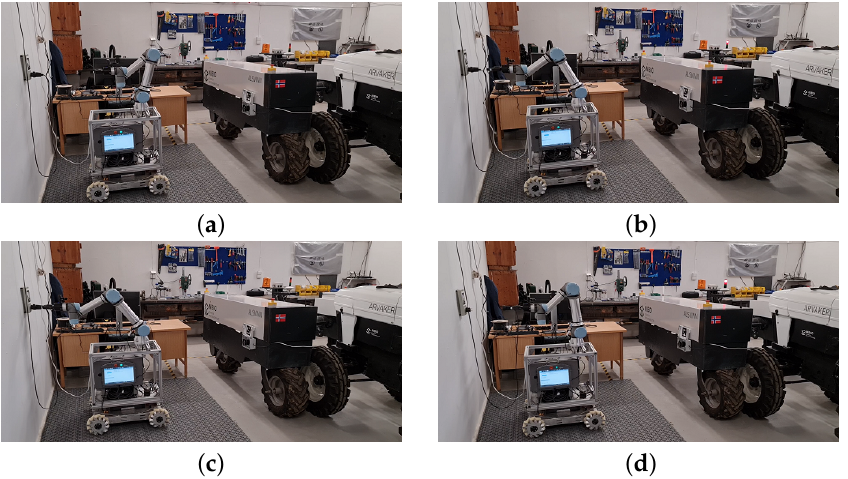
Figure 13. Sequence 2: Unplug the cable from the wall-plug and initiate next sequence. ( a ) Seq 2.1: Align the gripper to the wall-plug fiducial marker. ( b ) Seq 2.2: Move the gripper to the approach point. ( c ) Seq 2.3: Close the gripper to unplug the cable from the wall-plug. ( d ) Seq 2.4: Unplug the power cable from the